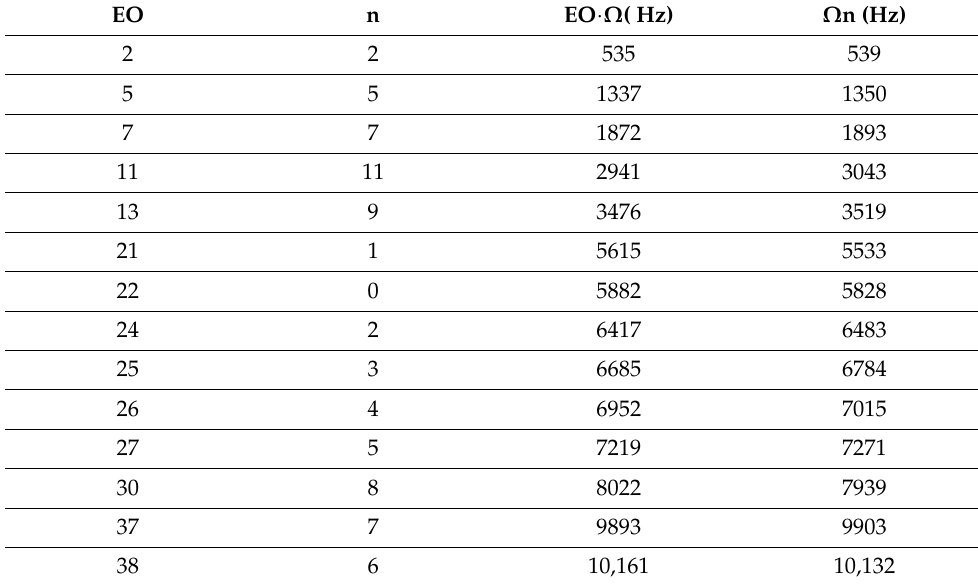
Table 1. Rotor67 bladed disk system resonance analysis